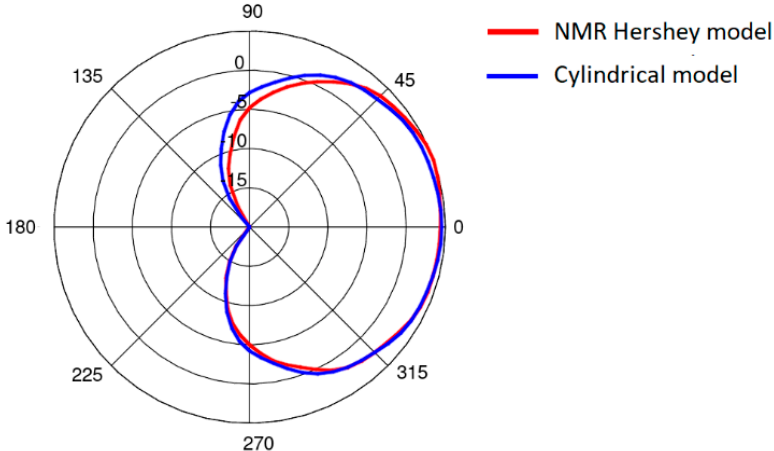
Figure 7. The on-chest antenna (antenna 2) radiation pattern in the horizontal plane obtained using the heterogeneous model and the simplified model.